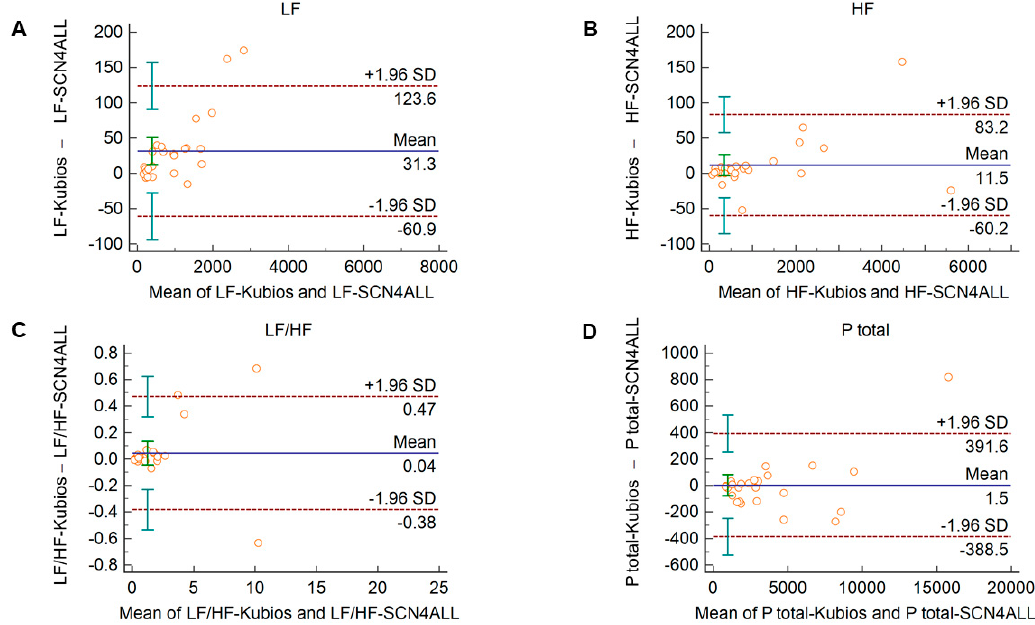
Figure 5. Bland–Altman plots of frequency-domain HRV/PRV parameters calculated by the SCN4ALL (indicated as ‘parameter name-SCN4ALL’) and the Kubios Premium HRV (indicated as ‘parameter name-Kubios’) algorithms from 2-min long PPG recordings obtained during cold pressor test. ( A ) Ptotal (total spectral power), ( B ) LF/HF (ratio of low frequency to high frequency), ( C ) LF (absolute power of the low-frequency band (0.04–0.15 Hz)), ( D ) HF (absolute power of the high-frequency band (0.15–0.4 Hz)) Bias is calculated as the mean of differences (indicated as ‘Mean’—blue solid line) and is presented with 95% confidence intervals (green) and +/ − 1.96 standard deviations (SD) and their confidence intervals.